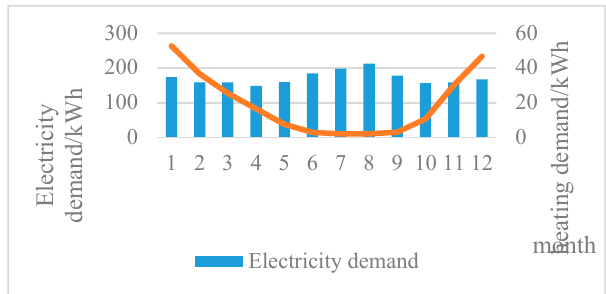
Figure 3. Daily energy consumption of simulation building each